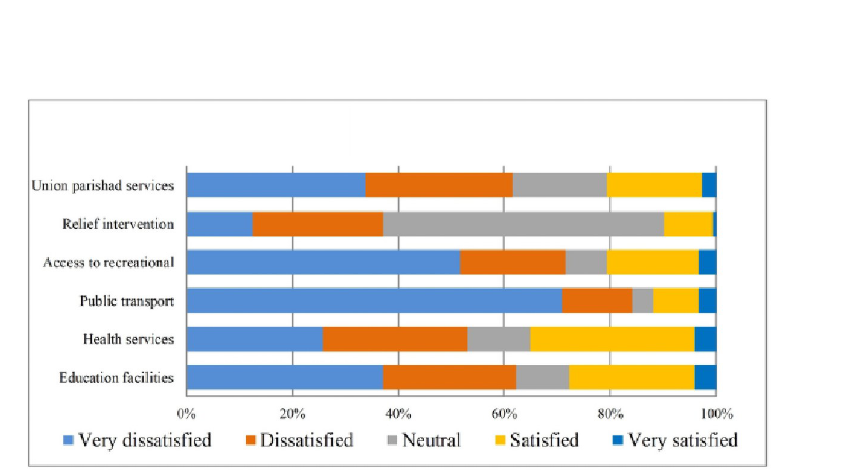
Fig 4. Satisfaction with public services and facilities. Source: Authors’ compilation, 2019.